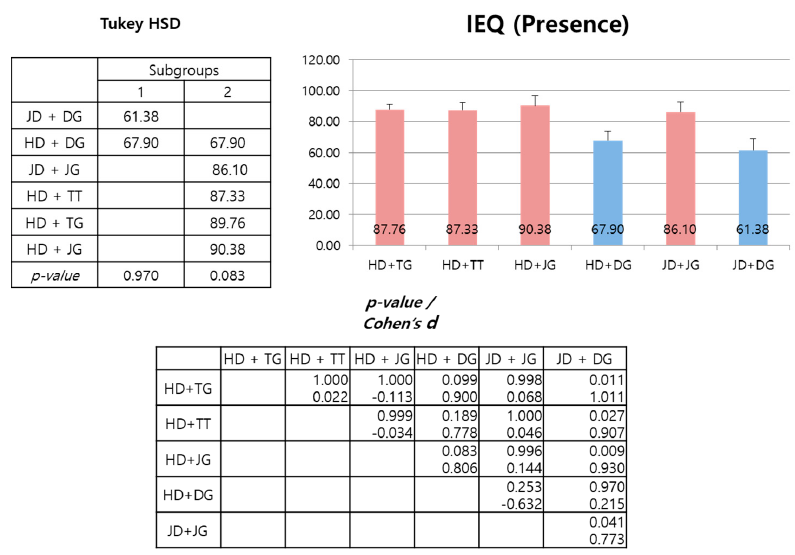
Figure 10. The IEQ (immersion experience questionnaire) scores for the six interfaces. Drag’n Go movement control showed the worst performance.